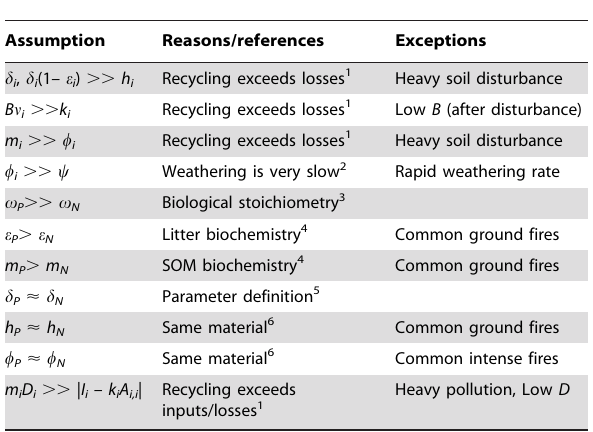
Table 2. Parameter assumptions for analytical simplifications.